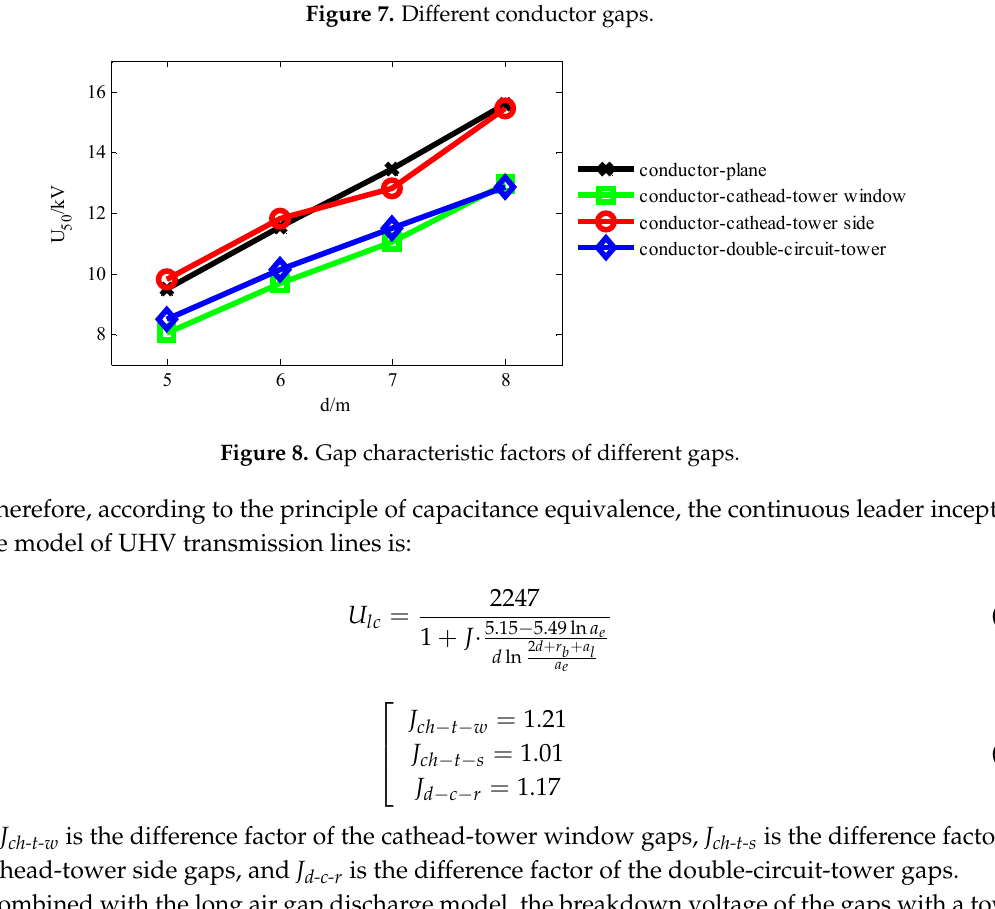
Figure 7. Different conductor gaps.